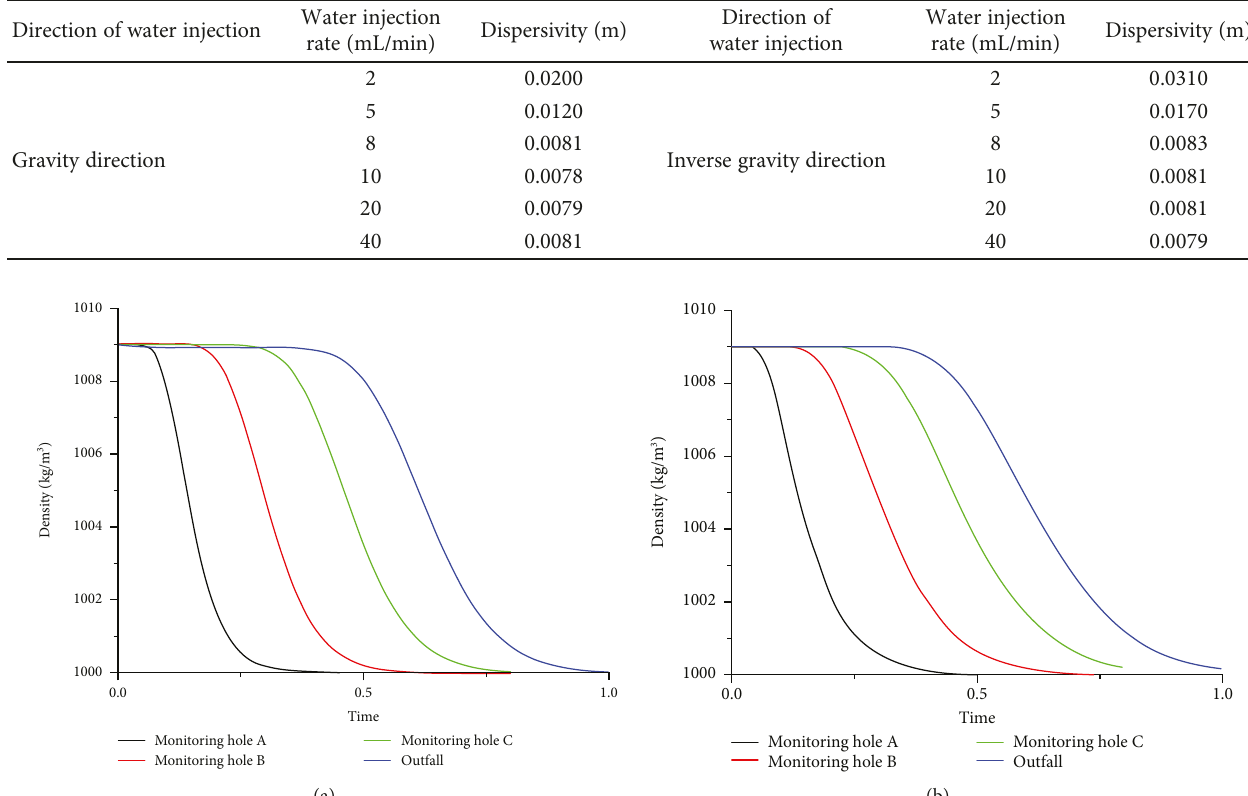
Table 5: Value of dispersion calculation for each group of tests.